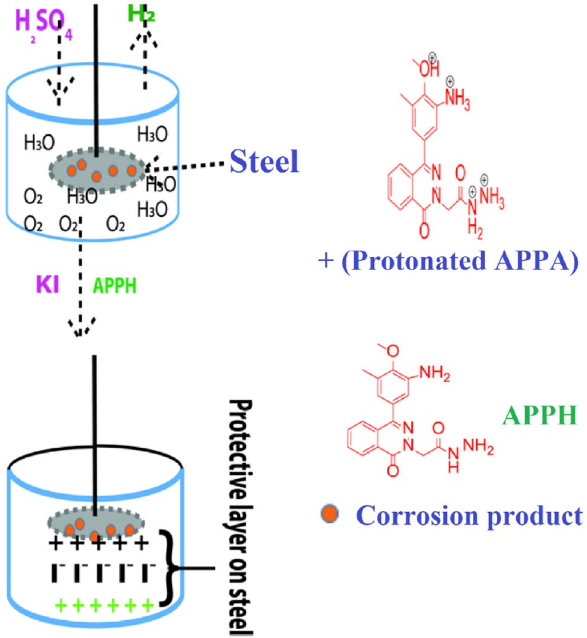
Figure 10. The mechanism of the APPH adsorption on the surface of LCS in 0.5 M H 2 SO 4